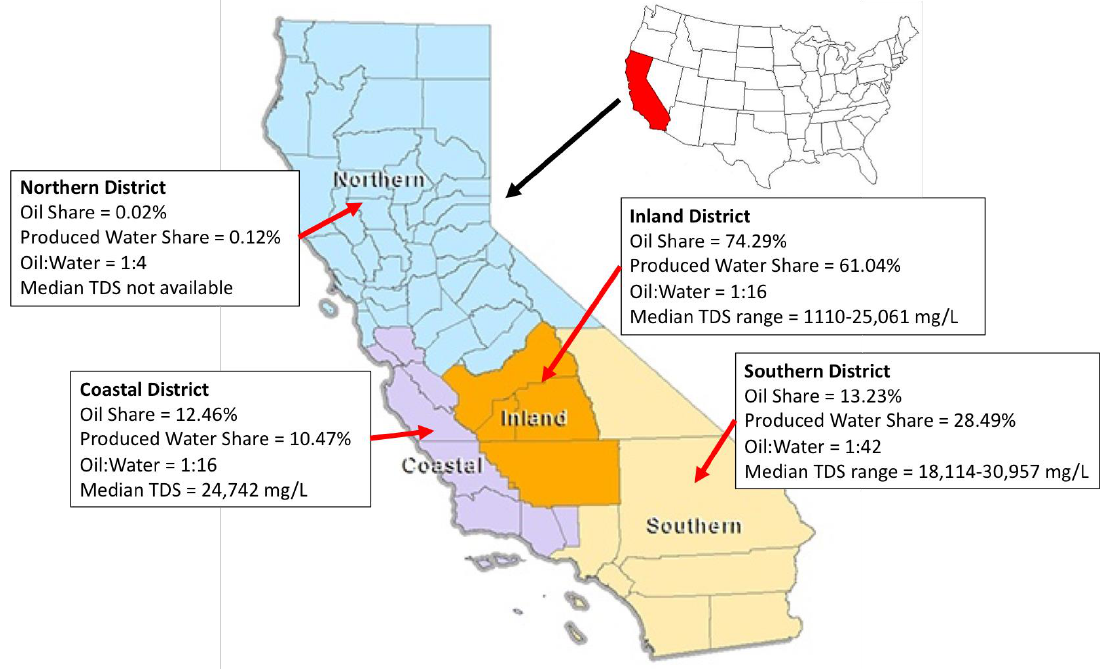
Figure 1. Oil production and produced water generation rates across di ff erent regions in California as well as variations in produced water total dissolved solids (TDS) levels across di ff erent California Division of Oil, Gas, and Geothermal Resources (DOGGR or CalGEM) districts.